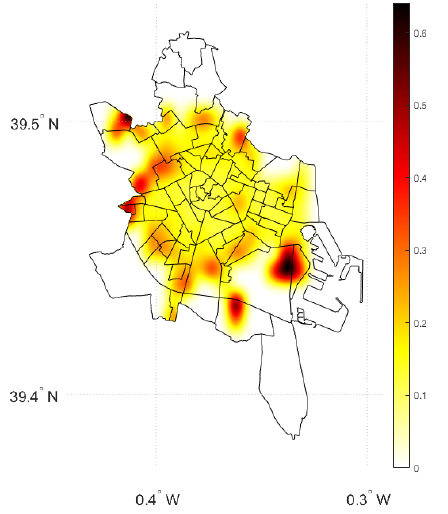
Figure 17. Volatility map in emergency calls in Valencia (2010 to